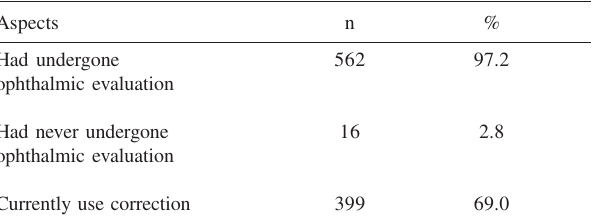
Table 3 - Aspects of the ophthalmic evaluation